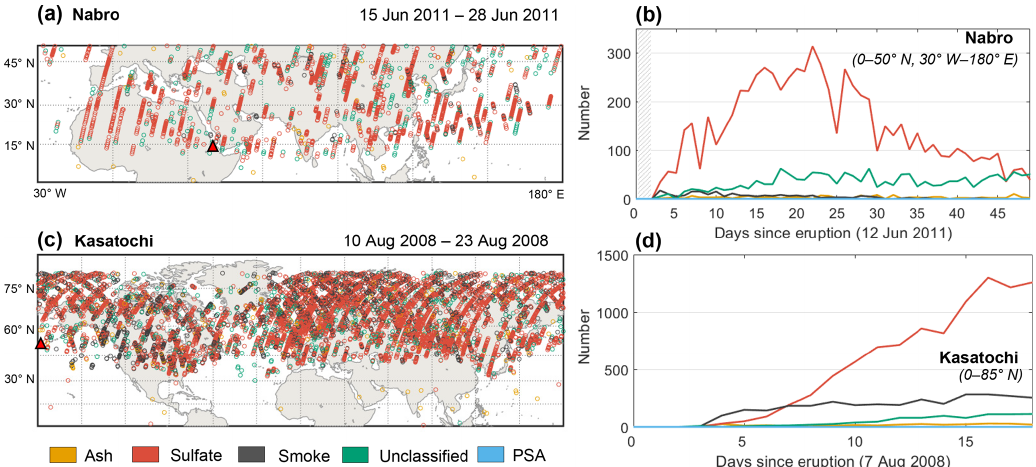
Figure 18. Same as Fig. 15 but for sulfate-dominated events.